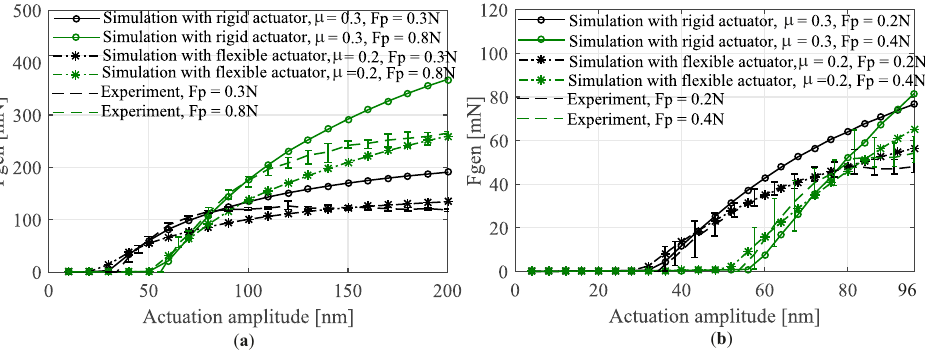
Figure 7. Dependency of the generated force F gen on the preload, the friction coefficient, the actuation amplitude and the radius of the hemispheres: ( a ) R = 1 mm; ( b ) R = 0.25